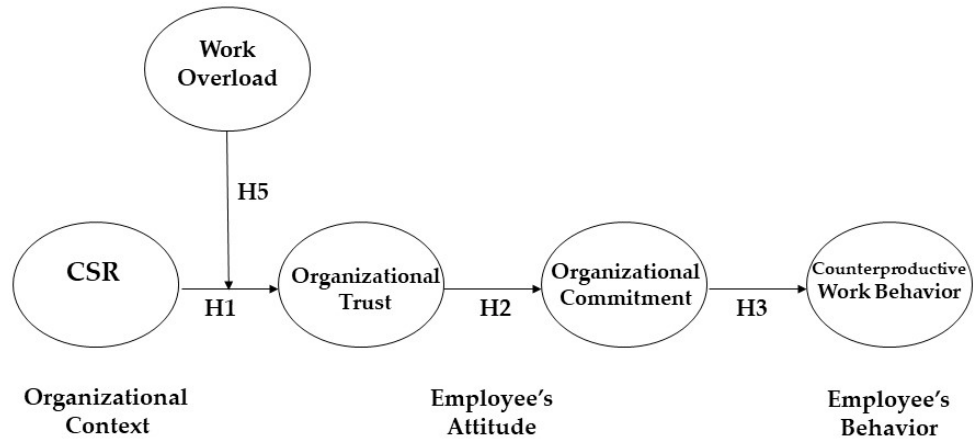
Figure 1. Theoretical model.